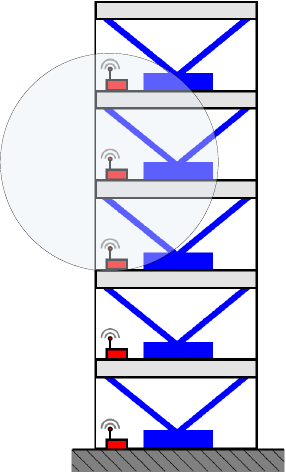
Figure 9: Wireless transmission range required by the multi-overlapping